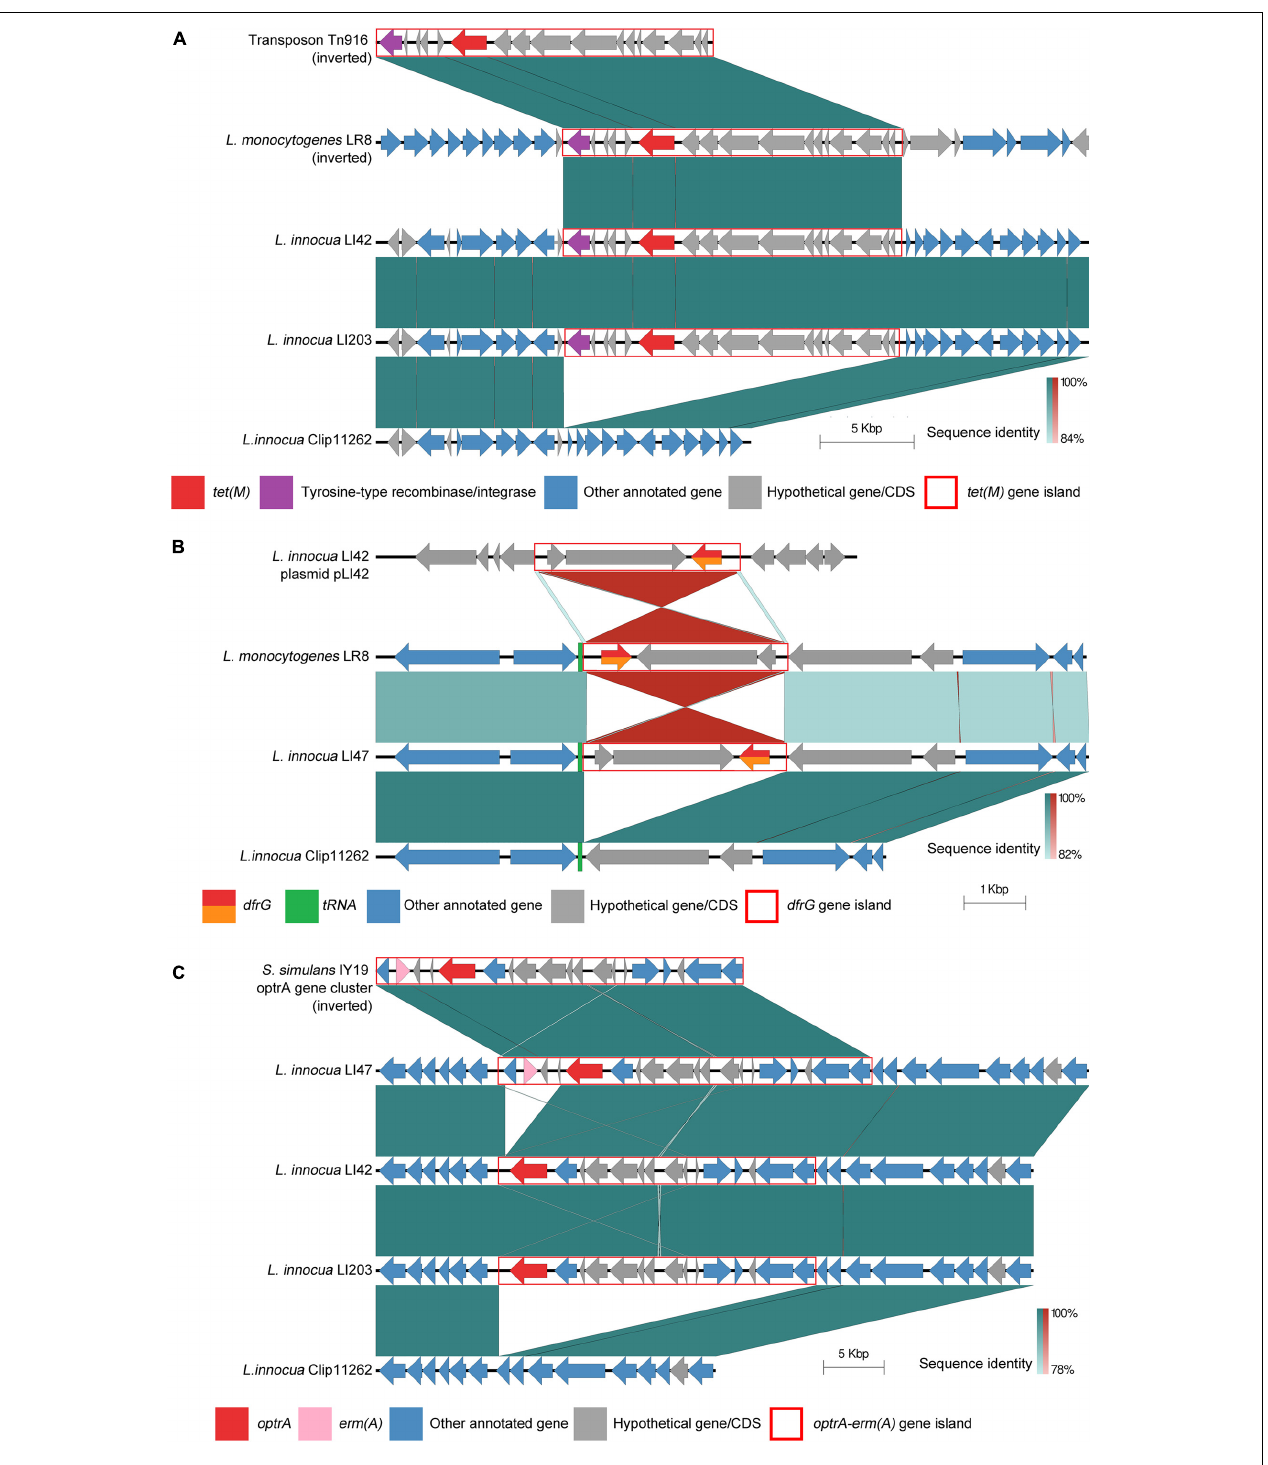
FIGURE 2 | Linear sequence comparison of resistance genes and its flanking region on chromosome. The tet (M) gene islands (A) , dfrG gene islands (B) , and optrA-erm (A) gene islands (C) and their flanking regions of LI42, LI47 or LI203 chromosomes was compared with their most closely related orthologs from nr/nt database and the susceptible L. innocua reference genome Clip11262. (A) Comparison of the tet (M) gene islands on LI42 and LI203 chromosomes with L. monocytogenes LR8 and transposon TN916. (B) Comparison of dfrG gene island in LI47 chromosome with plasmid pLI42 and L. monocytogenes LR8 chromosome. (C) Comparison of optrA-erm (A) gene islands in LI47, LI42, and LI203 chromosomes with S. simulans IY19 optrA gene cluster. Resistance genes and genes related to insertion or recombination were highlighted. Resistance gene islands were marked in red frames. Green or red shades between each two sequences represented direct or inverted nucleotide identity between covered